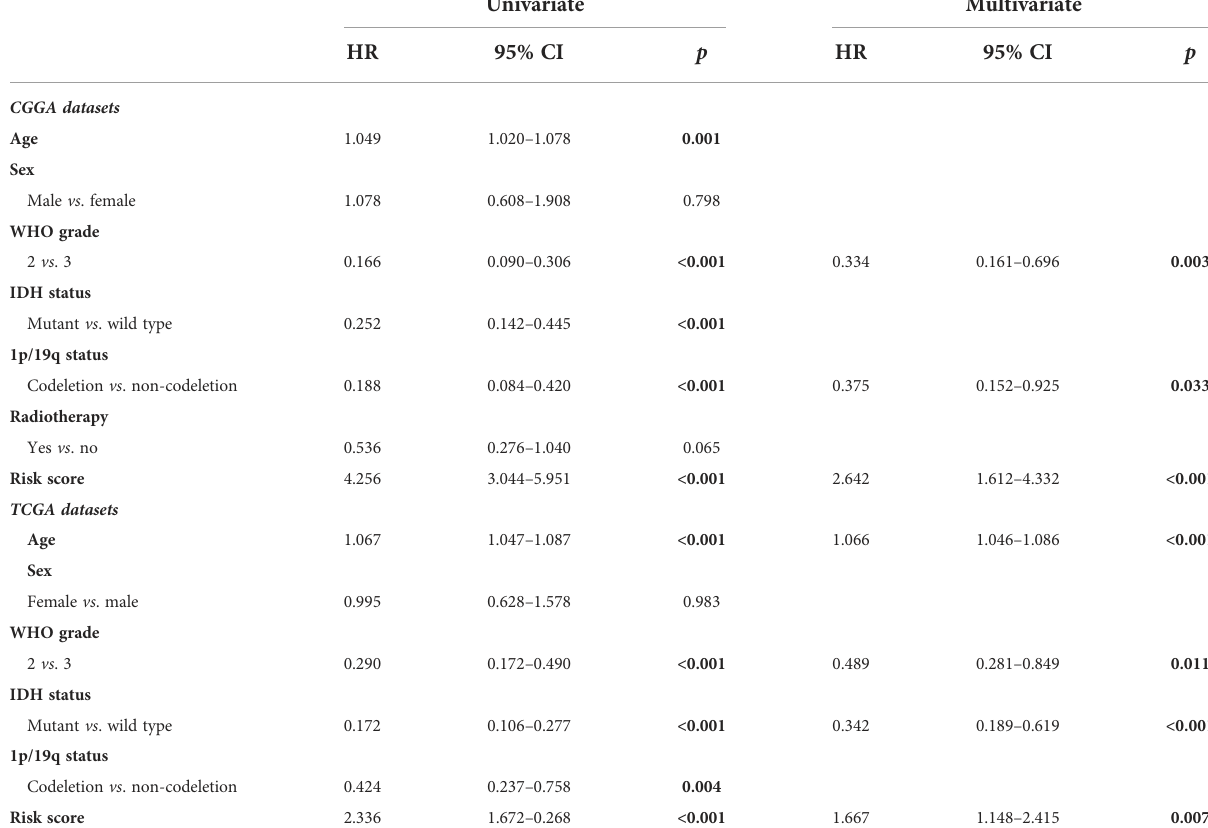
TABLE 1 Univariate and multivariate Cox analyses in CGGA and TCGA LGG